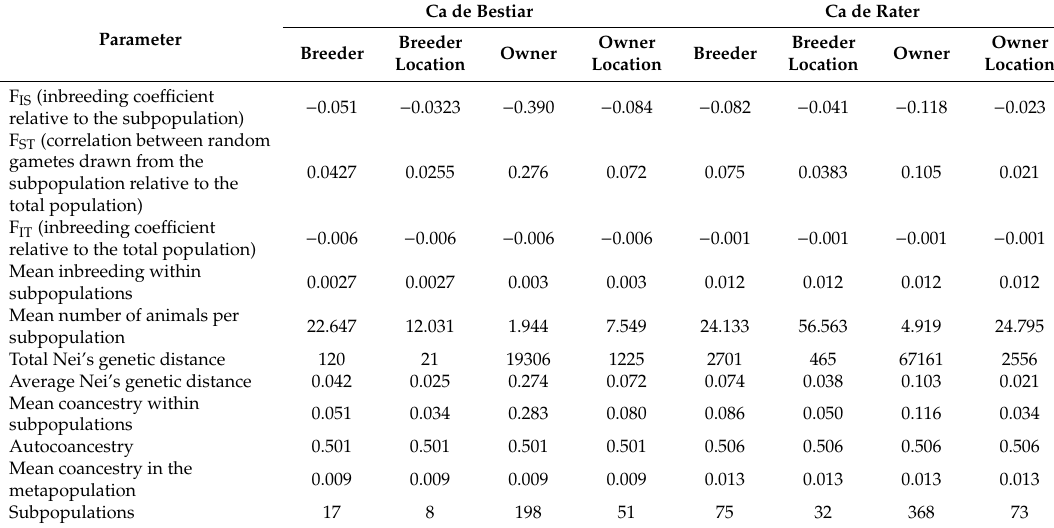
Table 5. Summary of Wright’s fixation